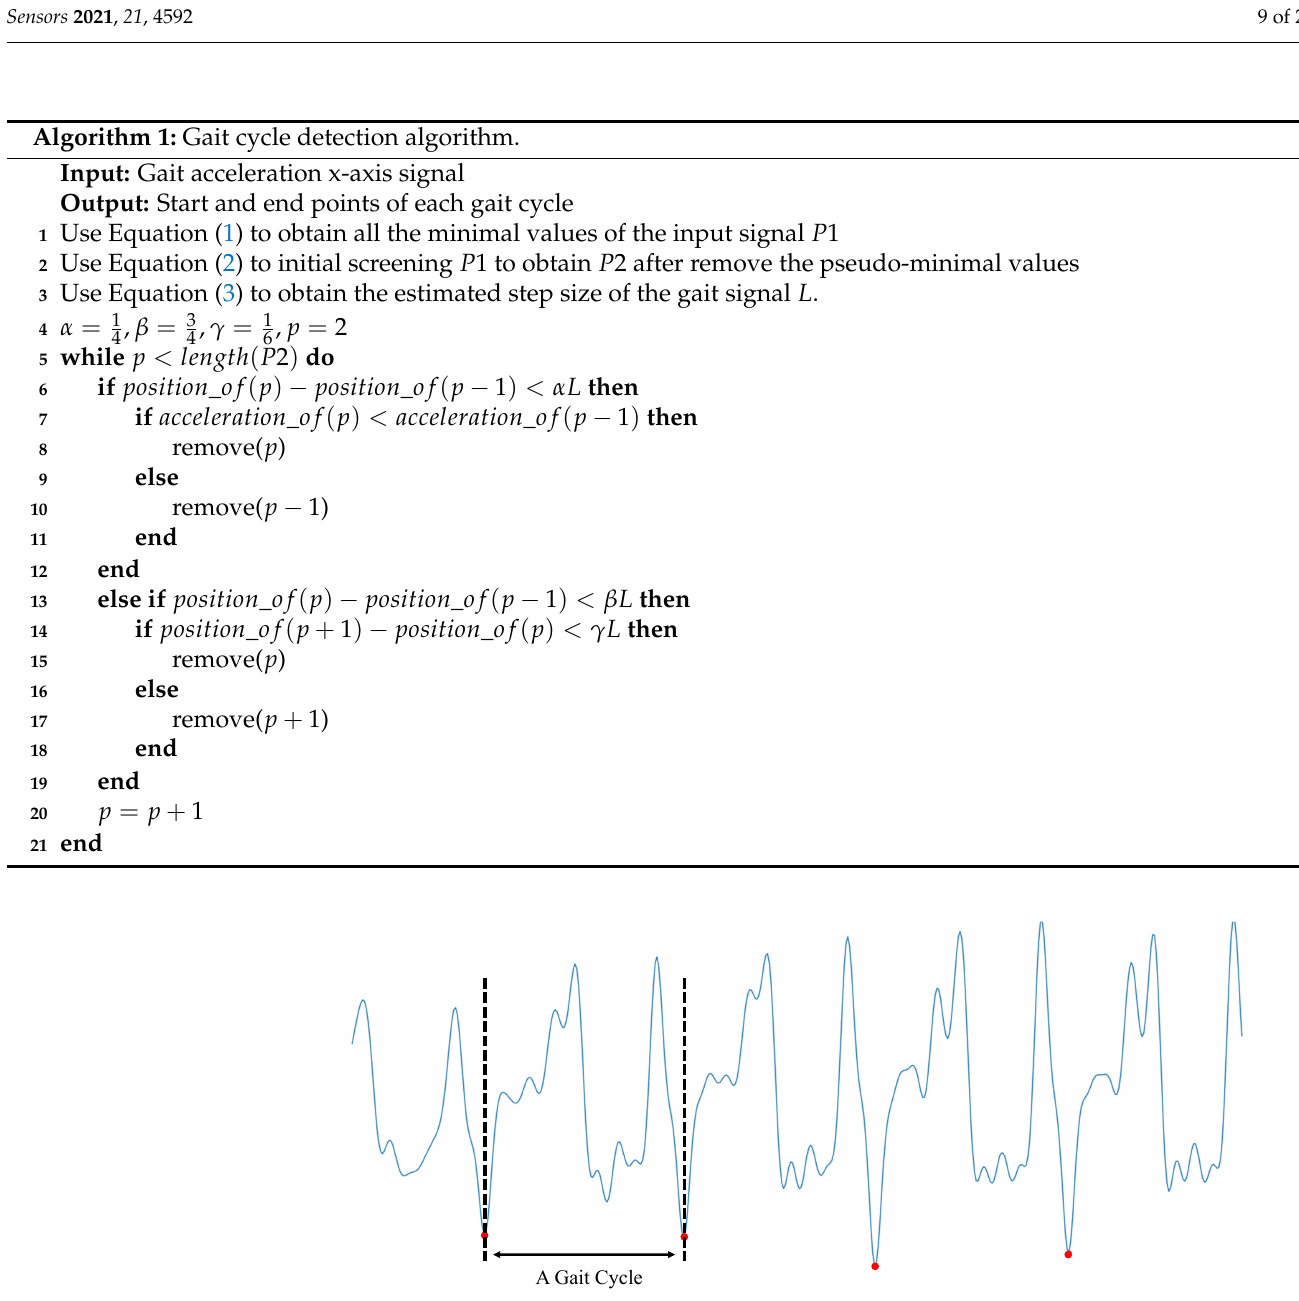
Figure 7. Gait cycle